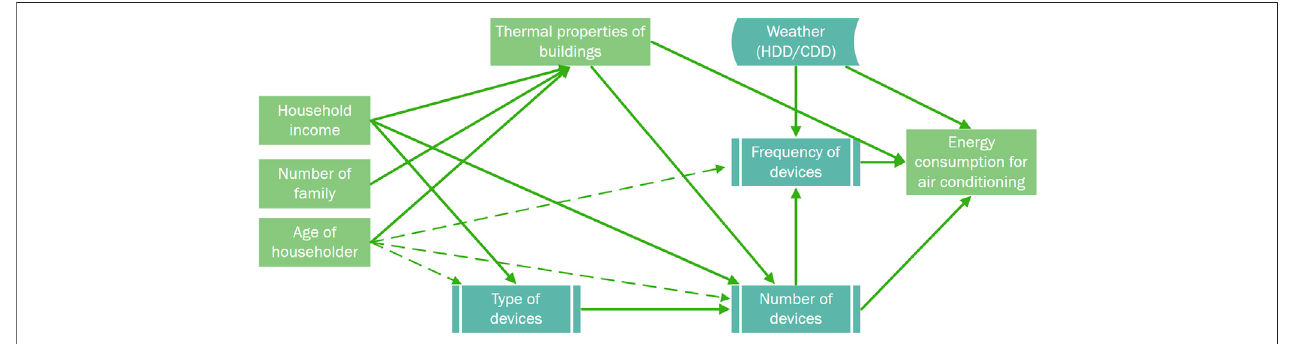
FIGURE 3 | Household features and air conditioning energy